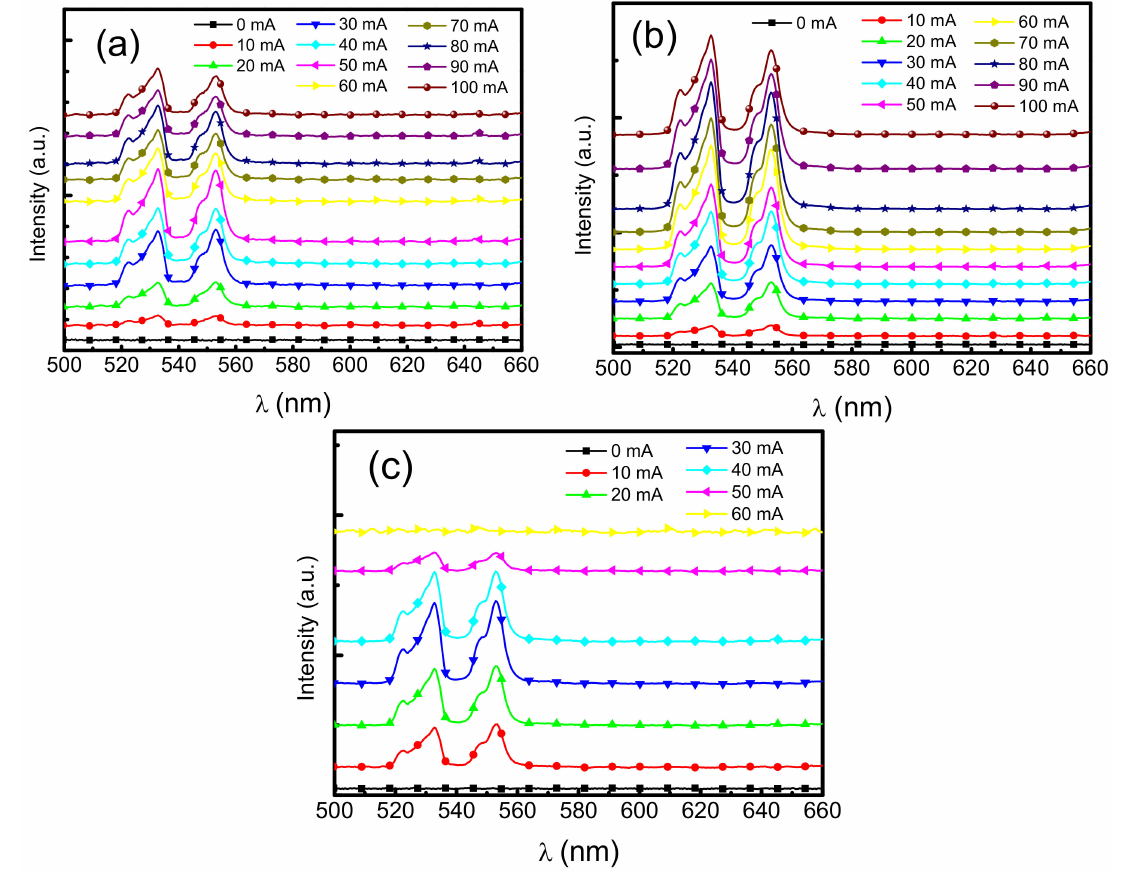
Figure 6. The electroluminescence spectra of samples ( a ) ST1; ( b ) ST2; and ( c ) ST3 measured at room temperature with different injection currents measured at room